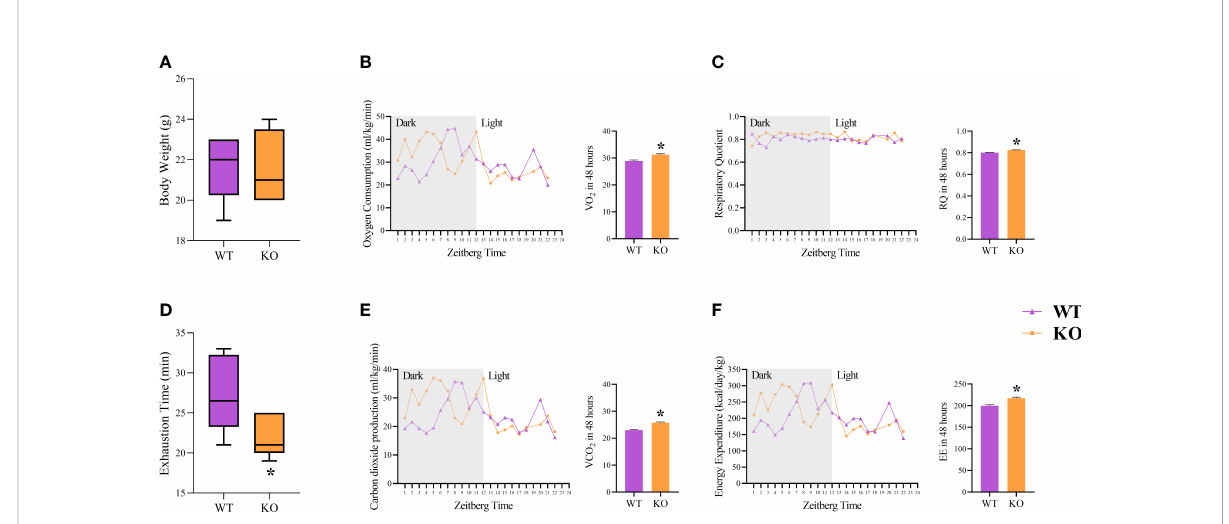
FIGURE 2 Metabolic outcomes and calorimetry. Body weight (g) (A) ; Exhaustion time (min) (B) ; Oxygen Consumption (ml/kg/min) (VO 2 ) (C) ; Carbon dioxide production (ml/kg/min) (VCO 2 ) (D) ; Respiratory Quotient (RQ) (E) ; Energy Expenditure (kcal/day/kg) (EE) (F) . Data correspond to the mean ± SEM of n=5 mice/group. *p ≤ 0.05 vs. WT. WT (sedentary; Basal), IL-6 KO (sedentary; Basal). The line graphs correspond to 24 hours, and the bar graphs correspond to 48